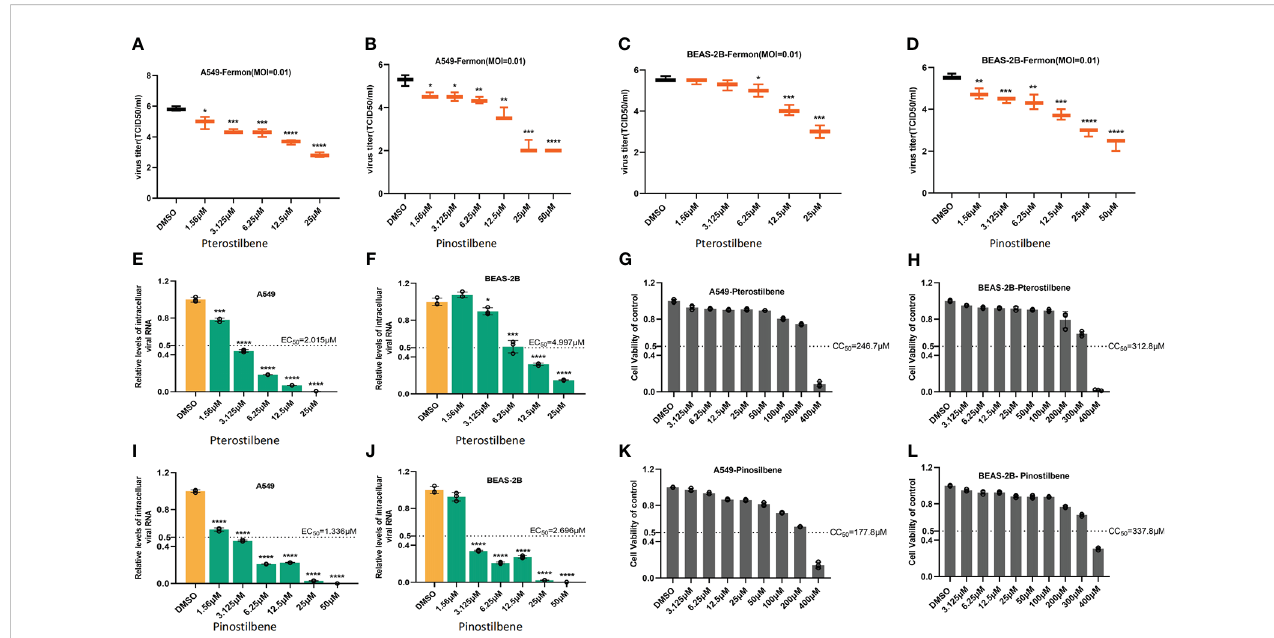
FIGURE 3 Pterostilbene (Pte) and pinostilbene (Pin) inhibit EV-D68 replication. (A – D) Determination of progeny virion production. Supernatants were collected 24 h post-infection and viral titers were determined by standard plaque assay. (E – J) qRT-PCR assessment of EV-D68 RNA replication. (G – L) Cell viability assay. Cellular toxicity was evaluated by CCK-8 assay and is expressed as the percentage relative to DMSO vehicle-treated control cells. Experiments were performed in triplicate. Error bars indicate the standard deviation (*, P < 0.05; **, P < 0.01; ***, P < 0.001; ****, P < 0.0001). EV-D68, Enterovirus